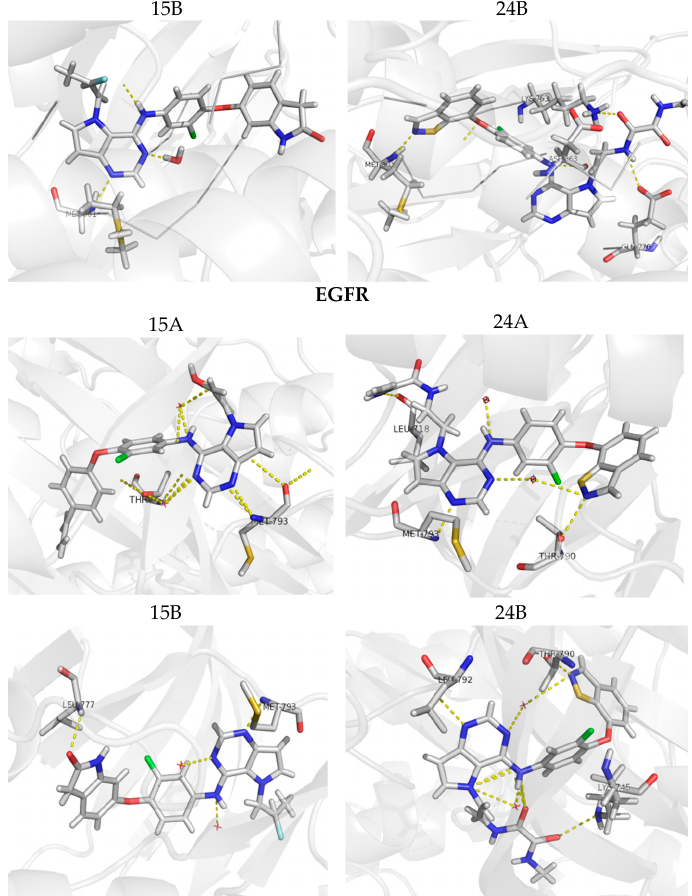
Figure 9. Molecular docking for the new proposed compounds (candidates to inhibit HER-2 and EGFR) from the CoMFA and CoMSIA models. The dash yellow lines indicate the interaction points between the proposed compounds and the main residues in the active sites.